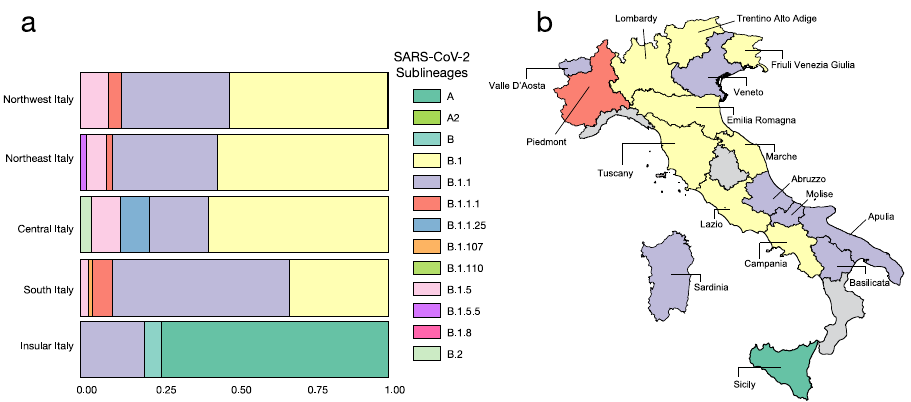
Fig. 2 Frequency and distribution of SARS-CoV-2 lineages and sub lineages in Italy. a Frequency of the lineages and sub lineages of SARS-CoV-2 among Italian macro regions. b Distribution of the most prevalent lineage and sub lineage across the country.